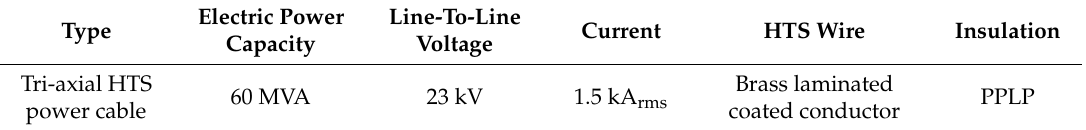
Table 1. Specification of the triaxial high-temperature superconducting (HTS) power